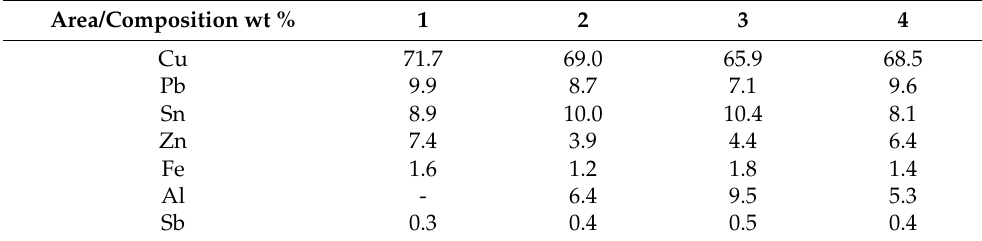
Figure 3. Optical microscopy of studied areas 1–4 on the NI sculpture, as shown in Figure 1. Table 1. Composition of studied locations on NI sculpture (Figure 1) obtained by portable XRF.